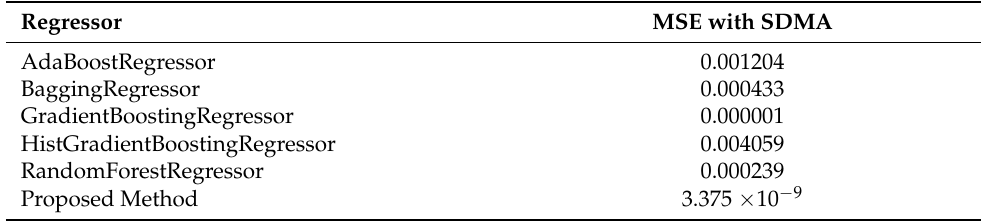
Table 3. MSE for individual regressors with SDMA as an extra feature, including the proposed